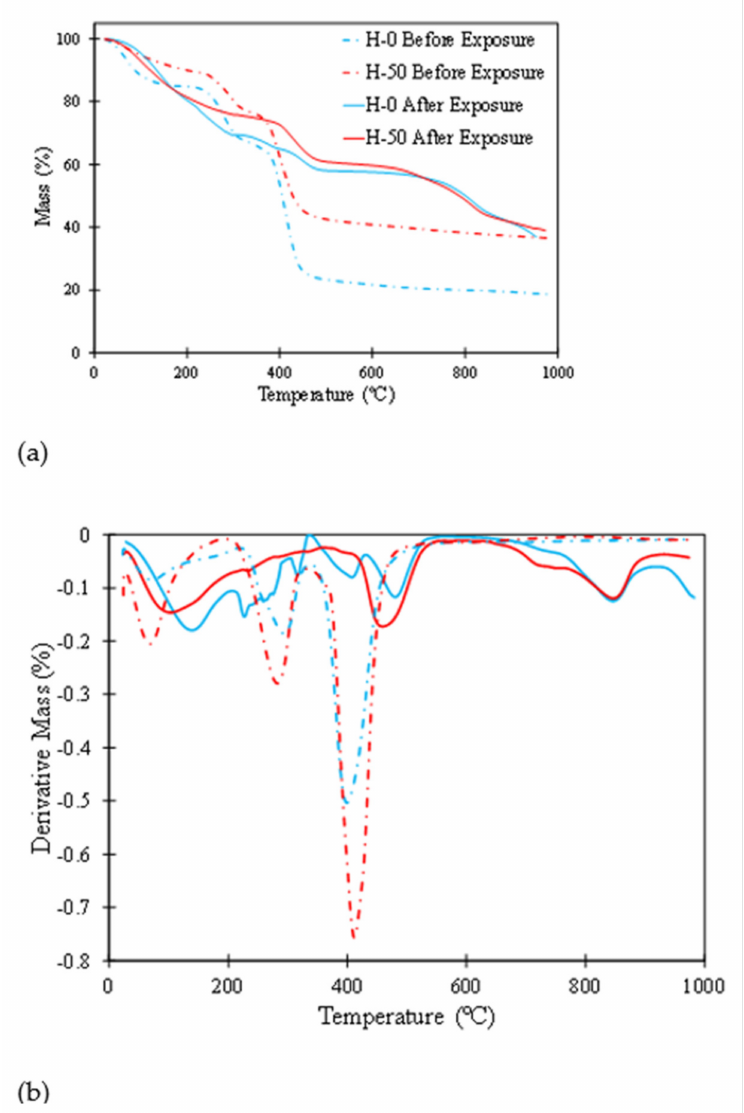
Figure 12. ( a ) TG and ( b ) DTG curves of H-0 and H-50 before and after exposure to the lime solution with increased